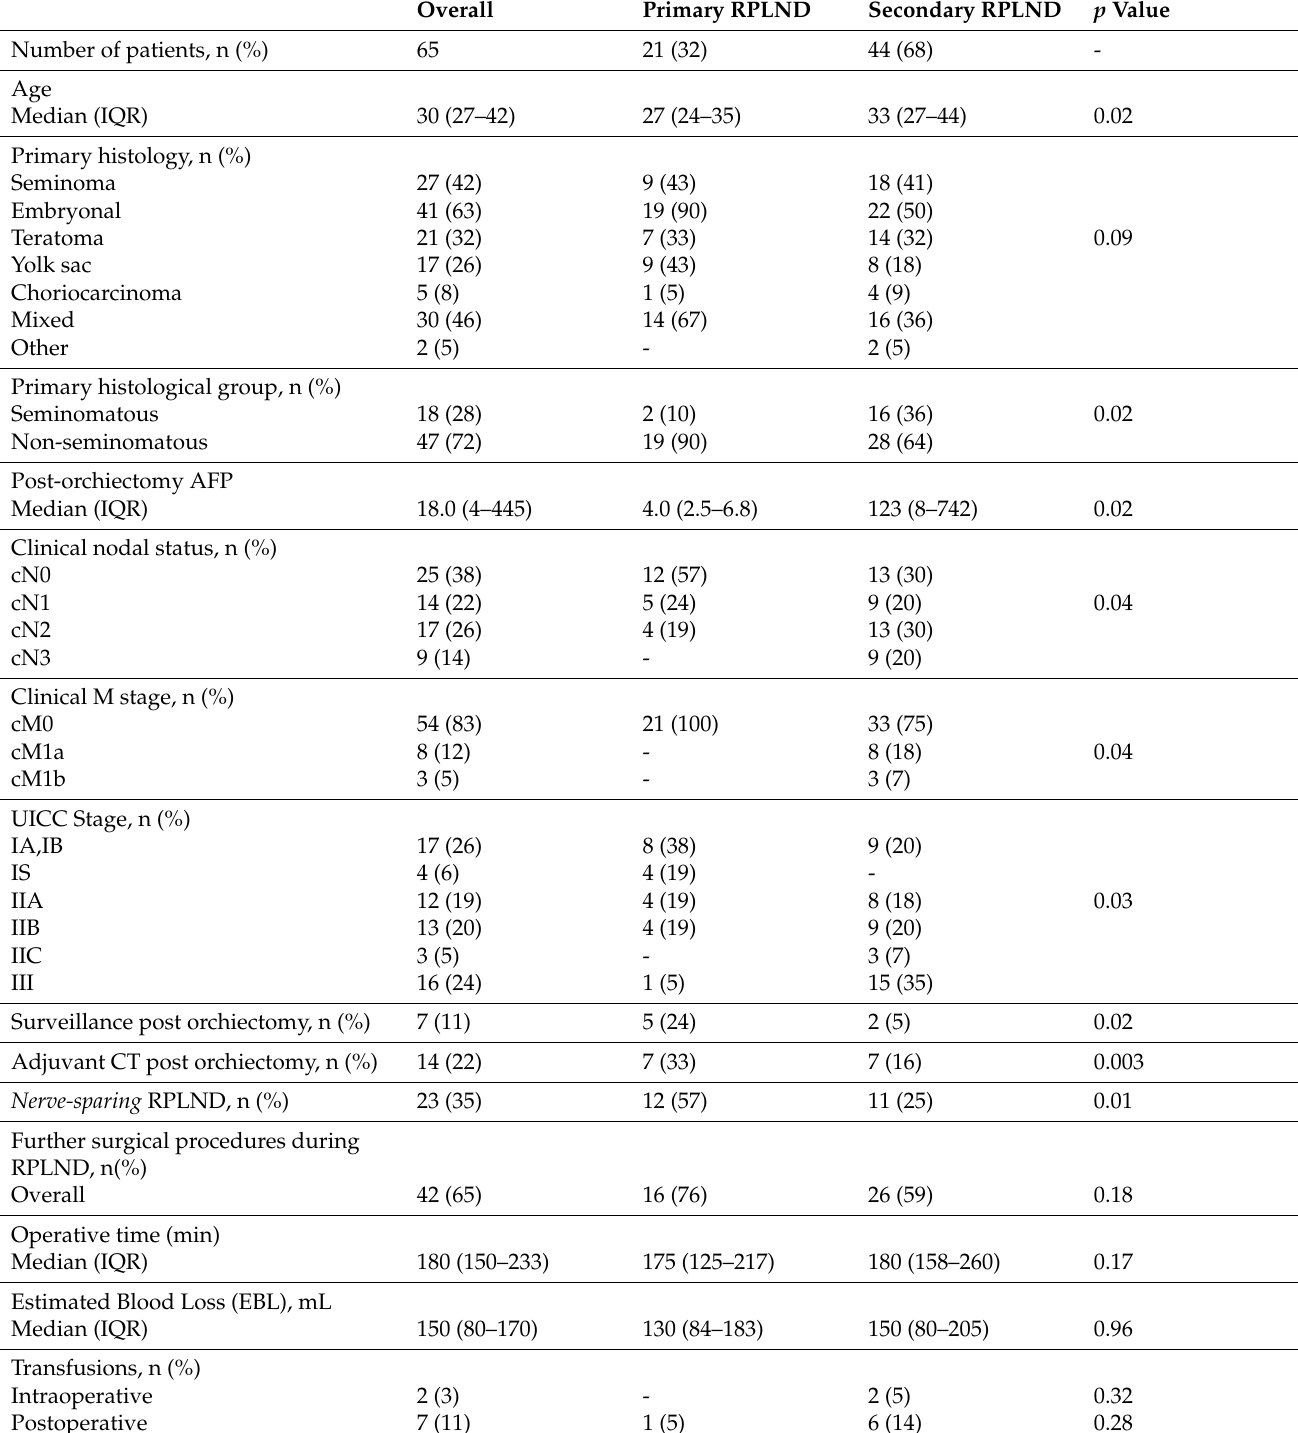
Table 3. Clinical and pathological characteristics of the study population among primary and secondary RPLND